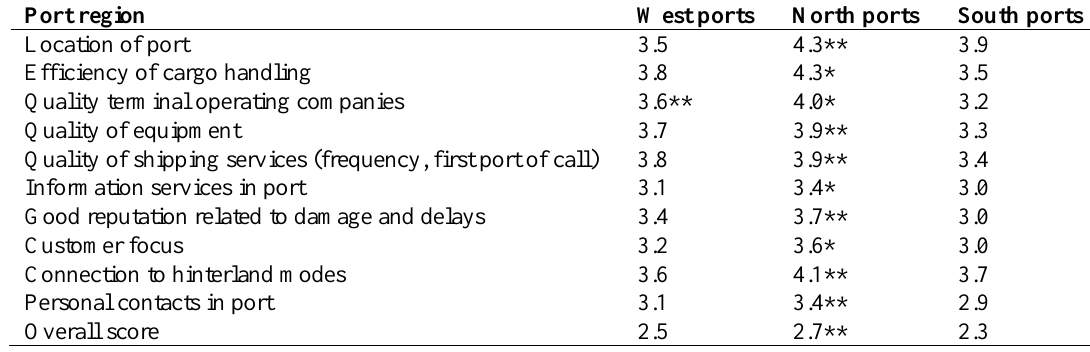
Table 5. The quality of North, West and South ports for Austrian cargoes